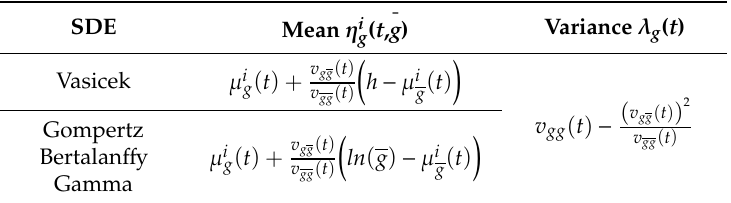
Table 3. Here, if g = d , then g = h , and if g = h , then g = d . Table 3. Mean and variance of conditional probability density functions.